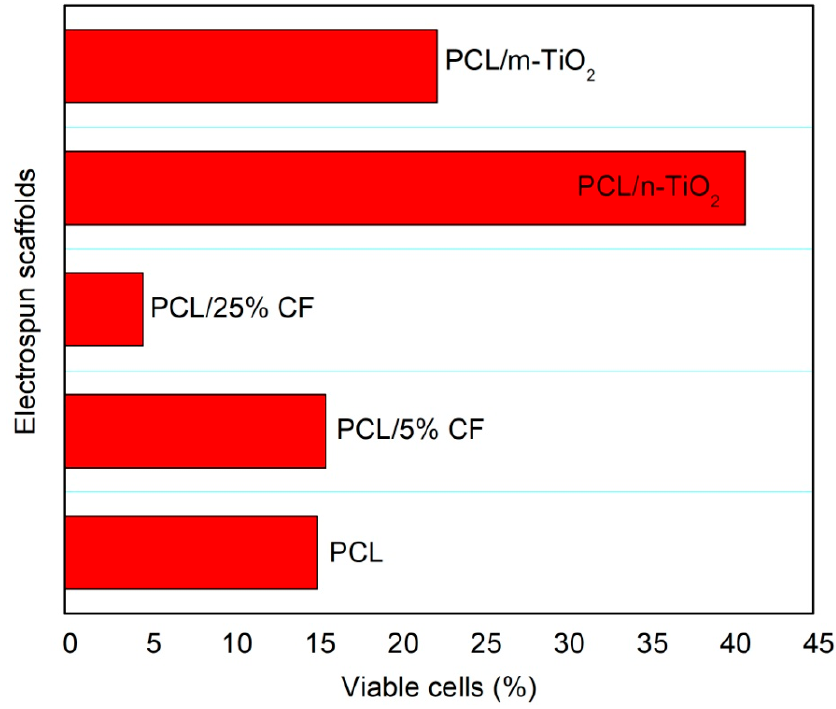
Figure 15. Percentage of viable cells measured by the 3-(4,5-dimethylthiazol-2-yl)-2,5-diphenyltetrazolium bromide (MTT) assay. 3.8. Immunocytochemistry (ICC) of the LSCs Cultured on the Electrospun Scaffolds